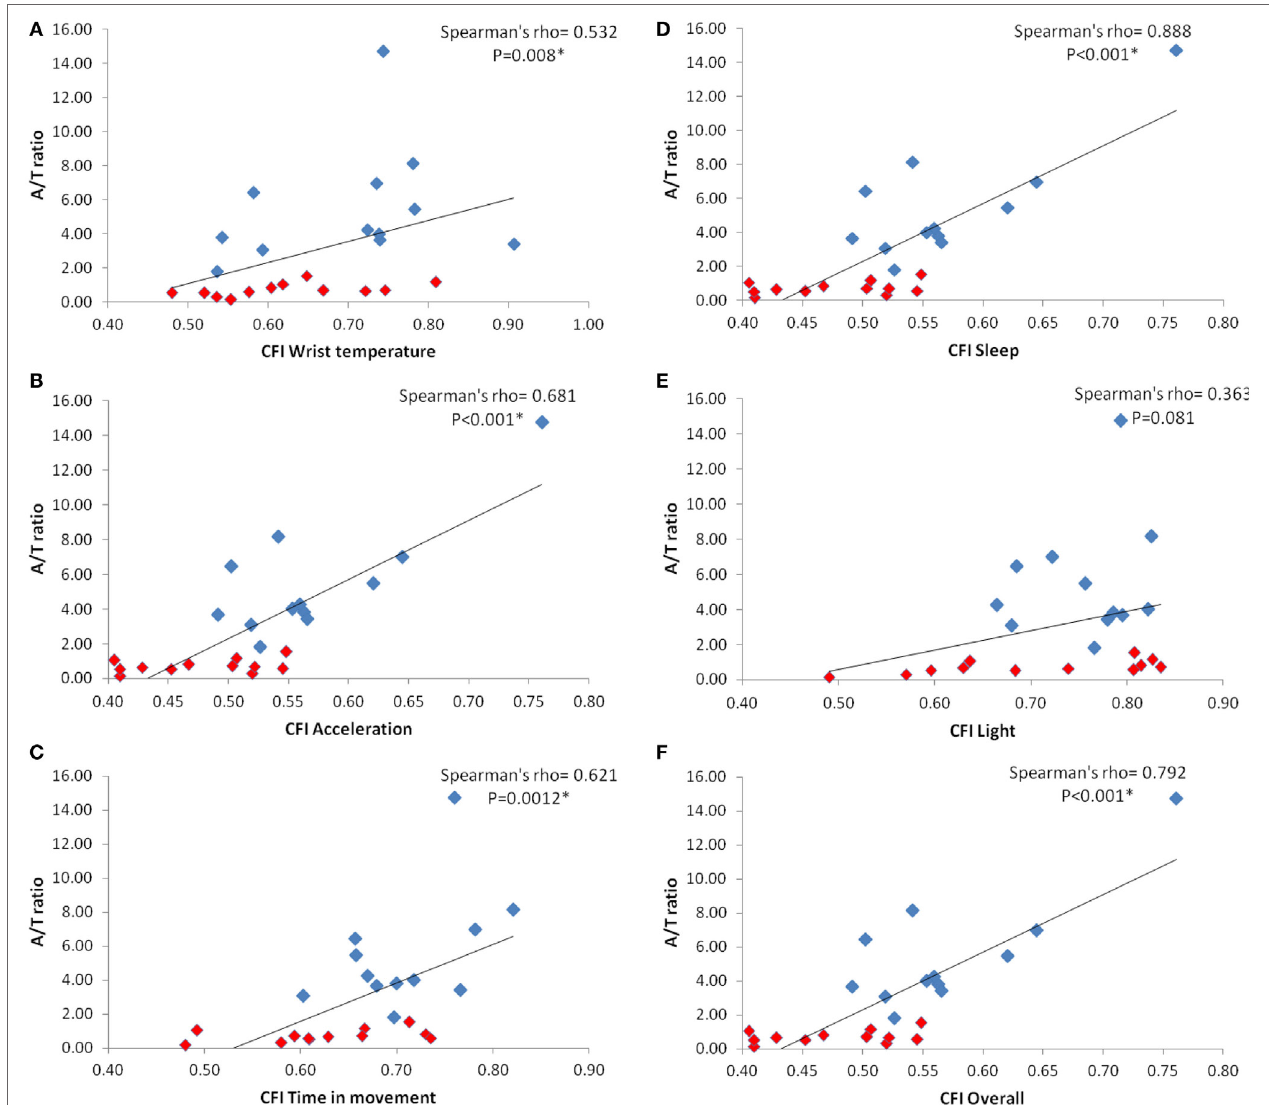
FigUre 6 | Correlations between M10V Acceleration/L5V Time in movement (A/T ratio) and the circadian function index (CFI), a marker of chronodisruption, for every circadian variable: wrist skin temperature (a) ; acceleration (B) ; time in movement (c) ; sleep (D) ; light exposure (e) ; and overall CFI (F) . Red squares correspond to Parkinson patients while blue squares indicate healthy controls. Spearman’s correlation coefficient rho and its probability value is shown on the upper right of every panel. * indicates statistical significance after Bonferroni’s